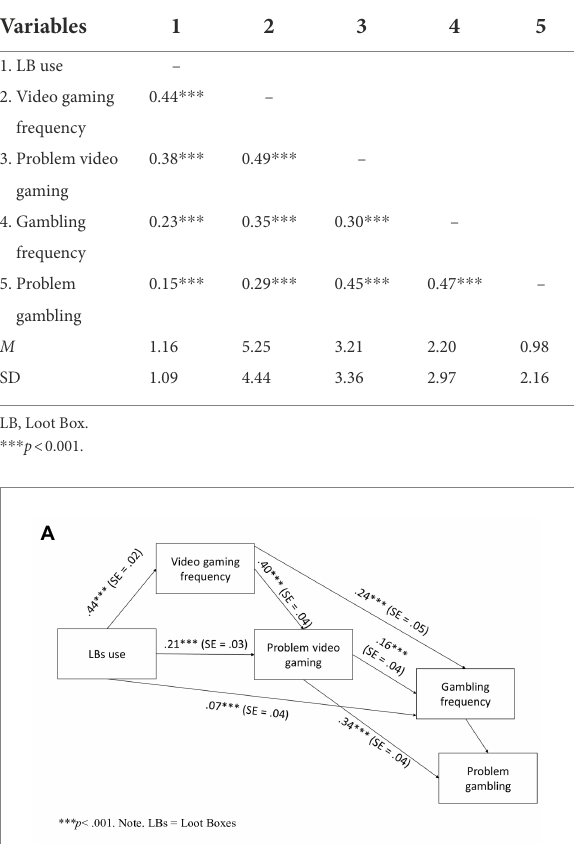
TABLE 6 Means, standard deviations, and correlations among LB use, video gaming frequency, problem video gaming, gambling frequency, and problem gambling, in Study 2.